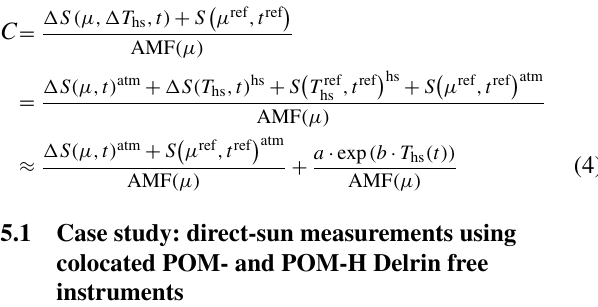
Figure 6. (cid:49)S of HCHO and SO 2 retrieved from POM-H Delrin free Pandora 167 head sensor at internal temperatures from 17 to 61 ◦ C using QHL at 7.5A (see text for information about thermal rates). Individual spectra integration time 12.9ms, and total exposure per measurement 240s. Fitting window 300 to 350nm. Fitting residual optical depth rms was 4 . 77 − 5 ± 4 . 29 − 6 during the entire measure- ment